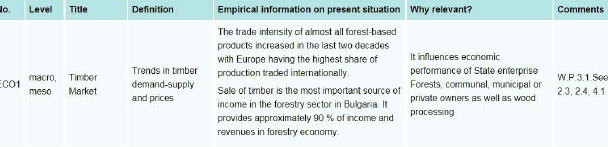
Fig. 2. Example of glossary of key factors.